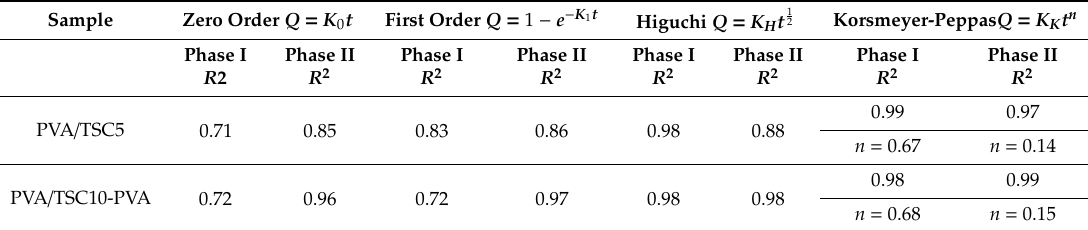
Table 2. Calculated regression coe ffi cients ( R 2 ) of di ff erent mathematical release models for the HapyTSCmB release kinetics from the PVA fiber mats a